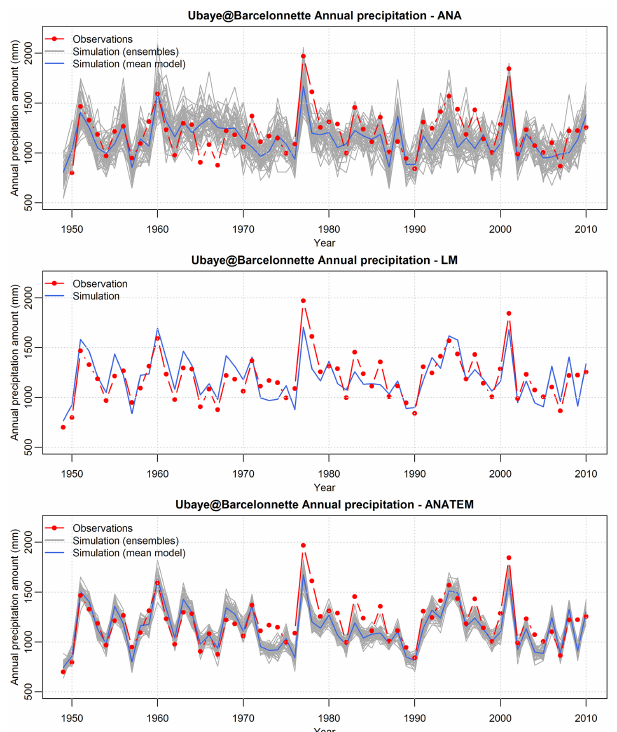
Figure 8. Annual time series of precipitation reconstructions for the Ubaye River at Barcelonnette watershed by the analogue (ANA), local (LM) and ANATEM